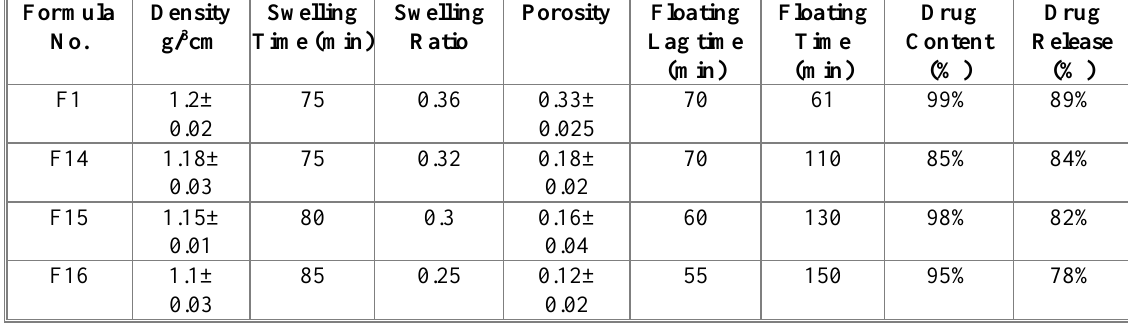
Table 7. Effect of Foaming Agent Amount on SPH Properties.